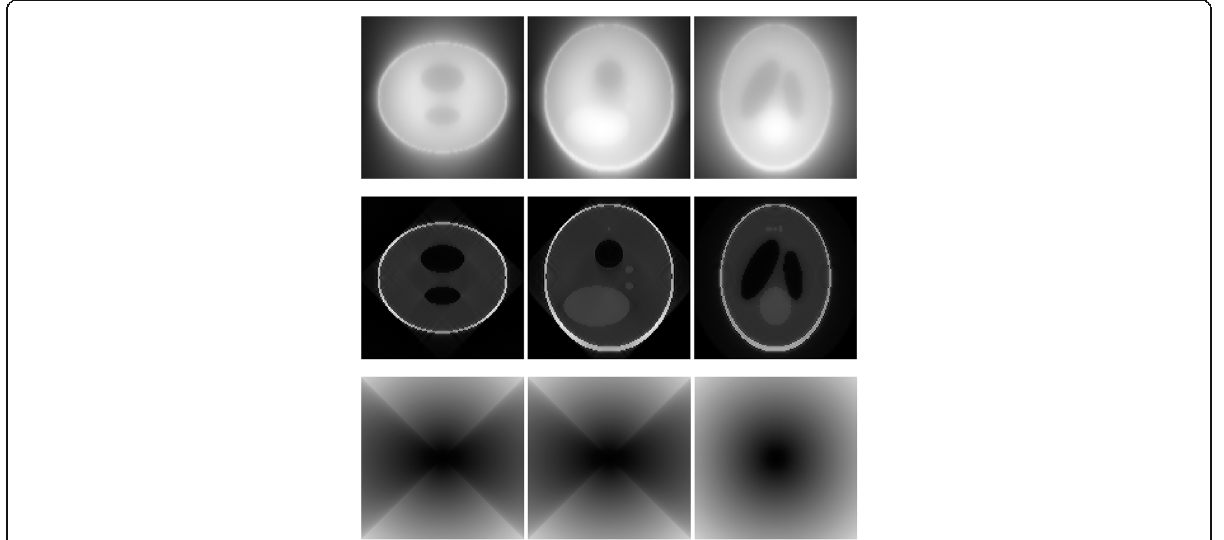
Fig. 16 Image reconstruction using non-TOF algorithm for the case of ψ = π /4. Row 1 : TOF backprojection. Row 2 : Final reconstruction. Row 3 : Tomographic filter H . Three central orthogonal cuts are shown for each row